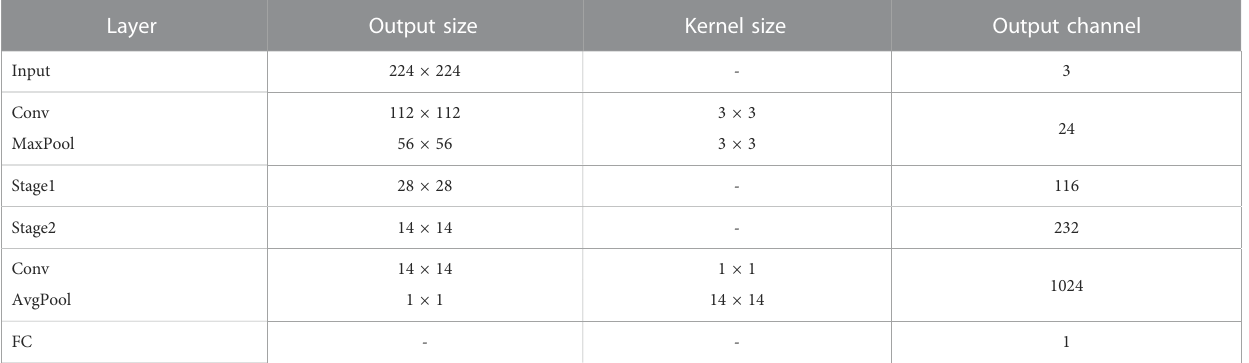
TABLE 1 The structure parameter information of